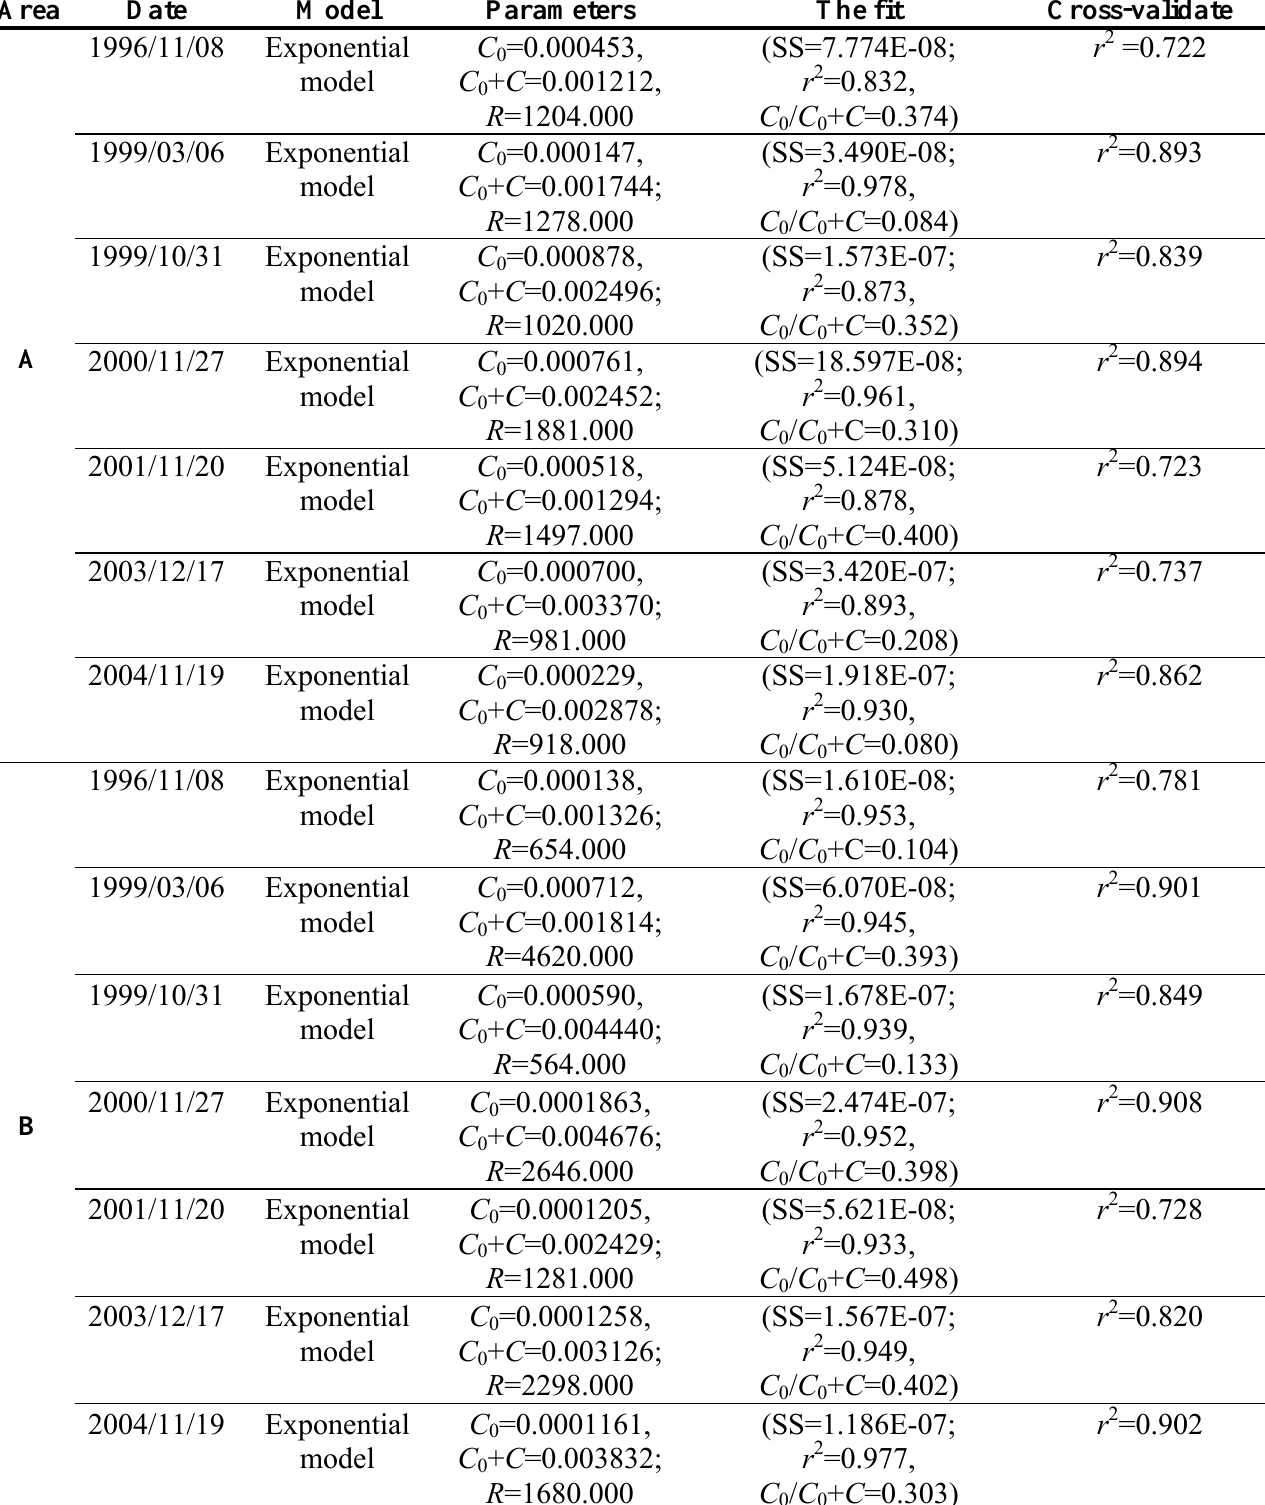
Table 2. Variogram models of NDVI